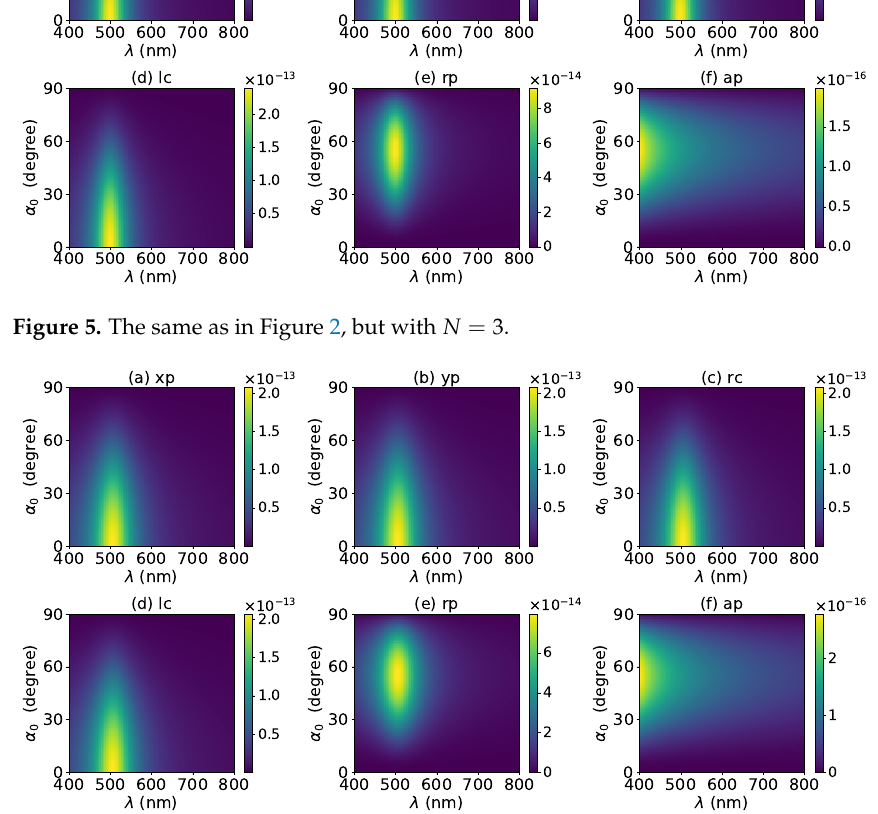
Figure 6. The same as in Figure 2, but with N = 4. Next, the axial optical force exerted on a graphene-coated gold nanosphere by a first-order ( l = 1) vector Bessel beam was considered, with a particular emphasis on the effect of the graphene coating thickness. Figure 7 shows the axial optical force on a gold nanoparticle, namely, the layer number of graphene coating is N = 0, by a first-order Bessel beam. Figure 7a–f correspond to linear, circular, radial, and azimuthal polarizations, respectively. A panel-to-panel comparison of Figures 2 and 7 shows that the LSPR peaks for l = 1 are located at the same wavelength as that for l = 0, since the LSPR frequency is the intrinsic frequency of the particle and is independent of the incident beam. Comparing to the case of l = 0, the LSPR peaks shift to a larger half-cone angle α 0 for linear and circular polarizations, while the peaks shift to a smaller α 0 for the radial polarization. This is because for l = 1, the electric fields are dominated by the component including the term ( σ ) . However, for linear and circular polarizations, a term P J l − (cid:107) is included. Thus, a larger 1 α 0 is necessary for l = 1 to generate the same dominant oscillating electric field of the incident beams as that for l = 0, and to generate the same LSPR. For the radial polarization, in addition to the term P (cid:107) , an additional term cot ( α 0 ) , which decreases with the increase of α 0 , is included. Thus, a smaller α 0 is necessary. Note that the LSPR peaks for the azimuthal polarization can be seen. This is because, for l = 1, the Bessel beam with the azimuthal polarization has a dominant electric field component including the term J l − 1 ( σ ) . Since this P (cid:107) = 1 electric field component has a term , which decreases with the increase of sin α 0 1 + cos α 0 α 0 , the LSPR peaks are located at a smaller α 0